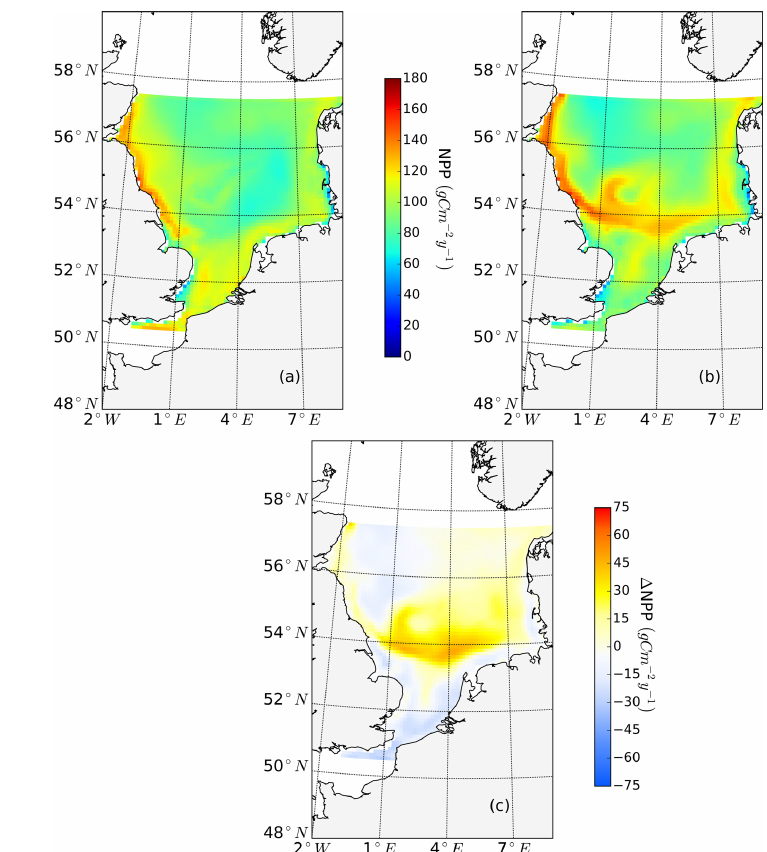
Figure C2. Mean annual net primary production for the analyzed period (1990–2015) of the non-tidal scenario (a) and tidal scenario (b) , both with SPM field implemented. The difference in the mean annual NPP of both scenarios is in panel (c) . The spatial coverage is smaller than original simulation domain since the SPM field data are available from 50.5 to 57.5 ◦